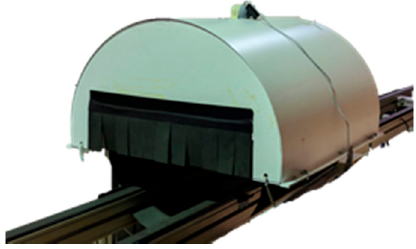
Figure 10. Quality control setup.